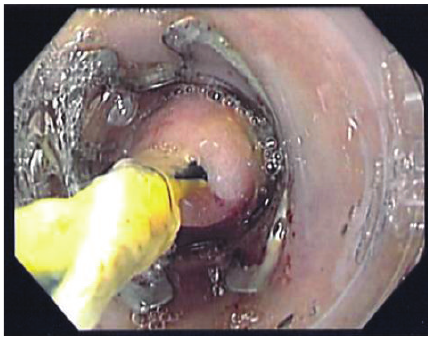
Figure 4: Bear Claw clip placed in the afferent loop of the Billroth II with mild edema surrounding this